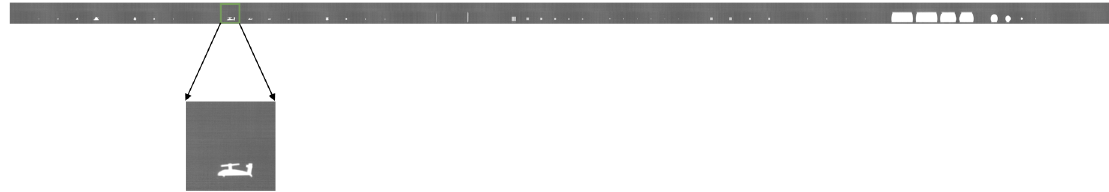
Figure 2. The single ‐ frame image obtained by the IRCSS. In this paper, its size is 768 (cid:3400) 40,000 . To make it clearer to display, we zoom in on a helicopter target. it clearer to display, we zoom in on a helicopter